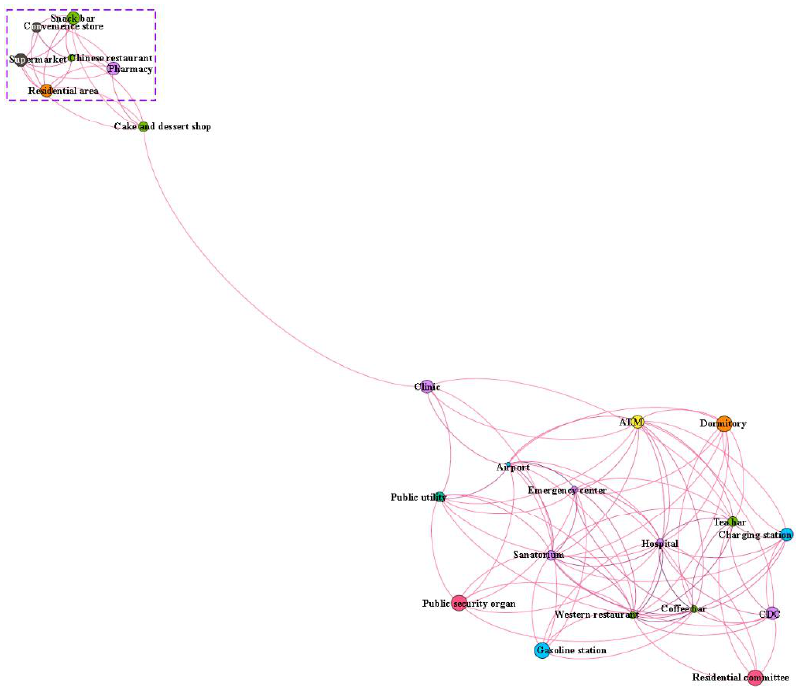
Figure 10. Complex network of urban function clusters under the lockdown of COVID-19.